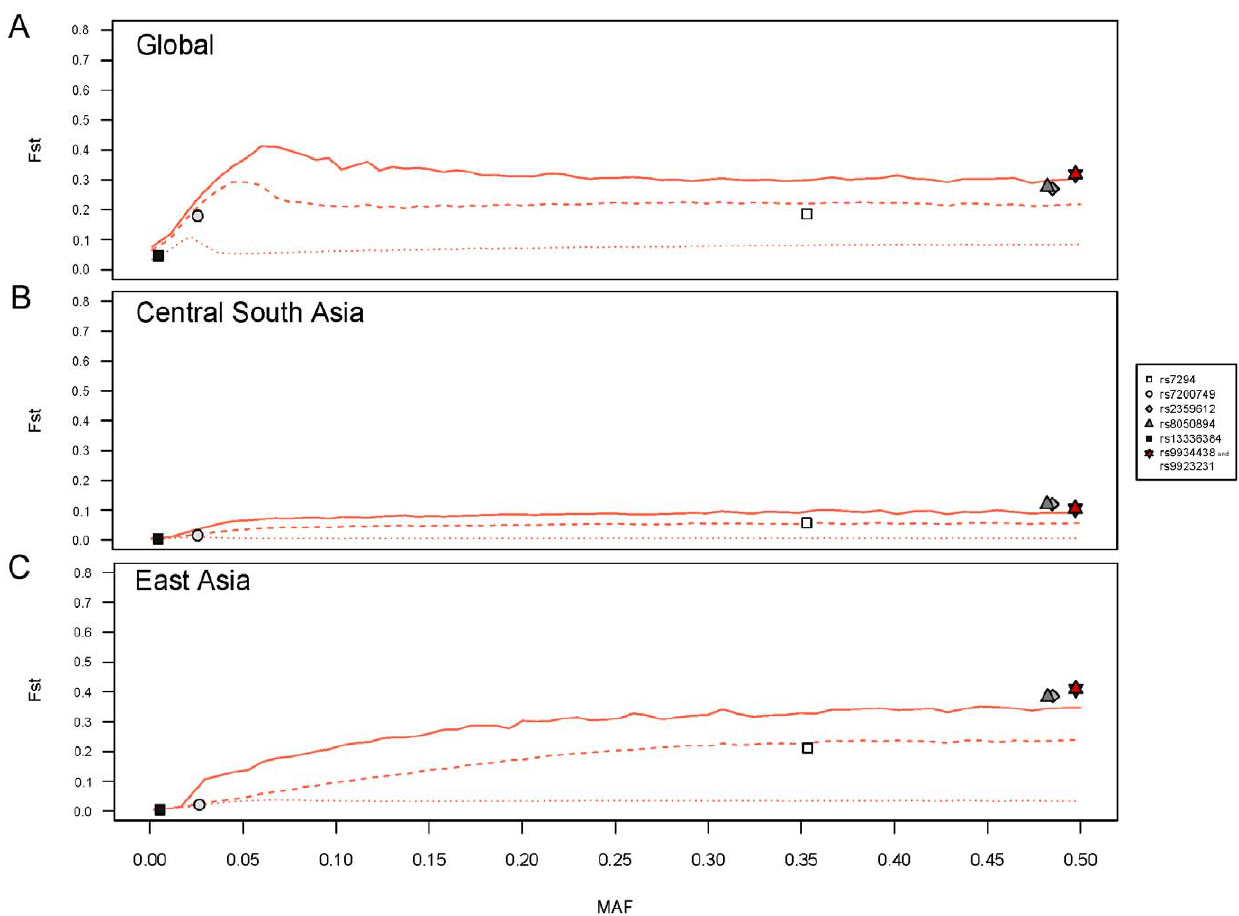
Figure 2. Atypical patterns of genetic differentiation observed for VKORC1 SNPs. Genome-wide empirical distributions of F ST values were constructed from 644,143 SNPs having a MAF $ 0.001 at the global level. Individual values of F ST calculated for each of the seven VKORC1 SNPs are plotted against their global MAF. The functional rs9923231 SNP is shown in red. The 50 th , 95 th and 99 th percentiles are indicated as dotted, dashed and full red lines, respectively.